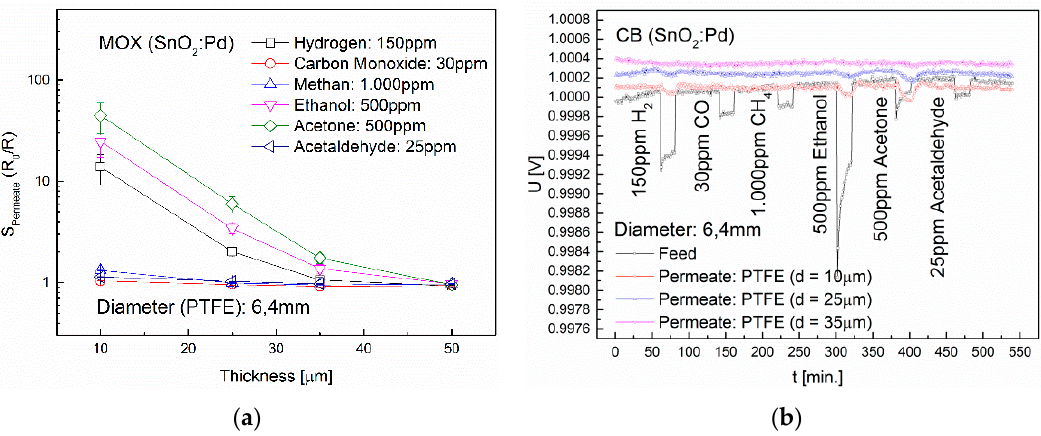
Figure 10. Influence of the thickness of a PTFE membrane on the diffusion of the gases H 2 , CO, CH 4 , ethanol, acetone and acetaldehyde. The membrane diameter is 6.4 mm. ( a ) Permeate signals of the MOX sensor; ( b ) Permeate signals of the CB sensor.